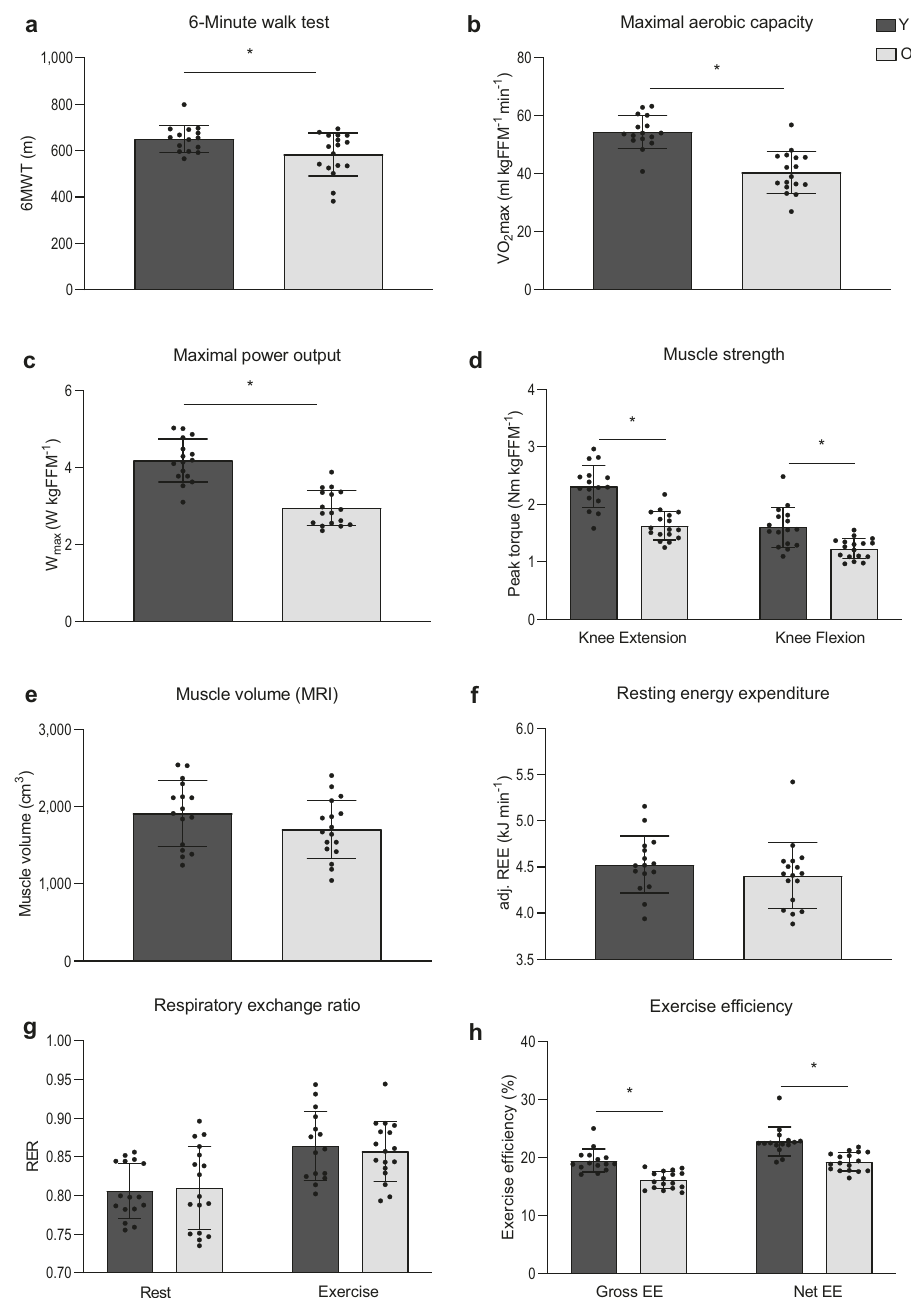
Fig. 1 Effect of aging on muscle health and exercise ef fi ciency. a Walking distance during the 6MWT performed on the Caren-system (Y, n = 14; O, n = 17). b Maximum rate of oxygen consumption measured during graded cycling exercise corrected for FFM (Y, n = 16; O, n = 17). c Maximal power output measured during graded cycling test (Y, n = 16; E, n = 17). d Muscle strength expressed as the extension and fl exion peak torque during an isokinetic protocol on the Biodex system and corrected for fat-free mass (Y, n = 16; O, n = 17). e Upper leg muscle volume measured by MRI (Y, n = 17; O, n = 17). f Resting energy expenditure adjusted for fat-free mass (Y, n = 15; O, n = 17). g Respiratory exchange ratio measured before, in resting conditions,